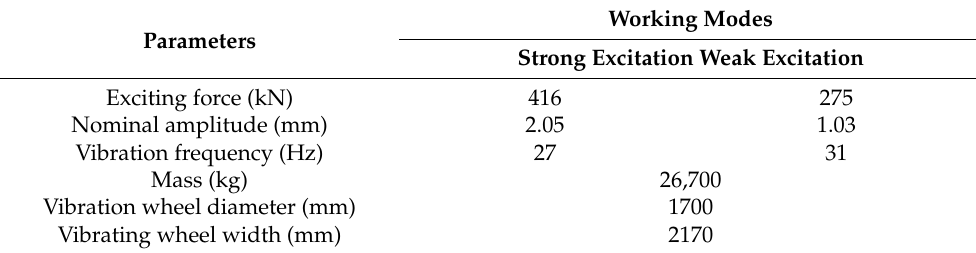
Table 1. Vibratory roller parameters.